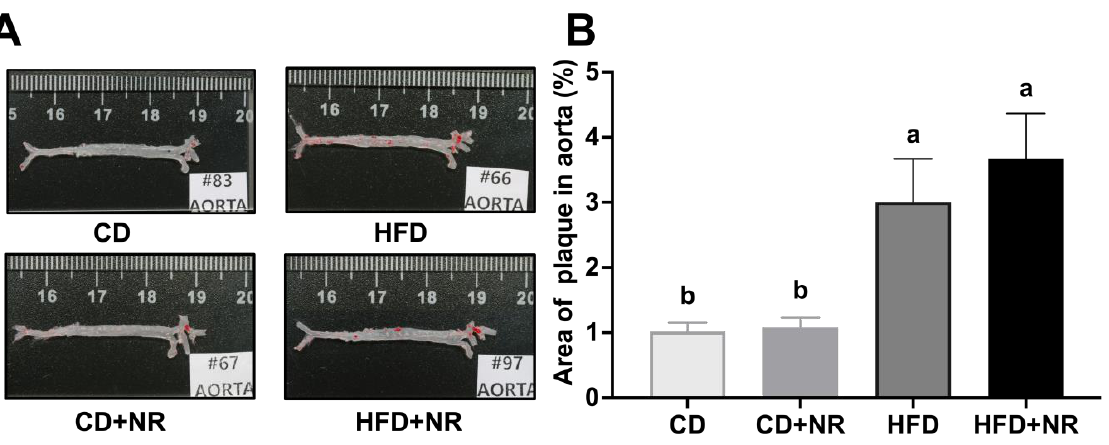
Figure 2. Histopathological changes of the entire aorta in ApoE −/− mice fed a CD or HFD, without or